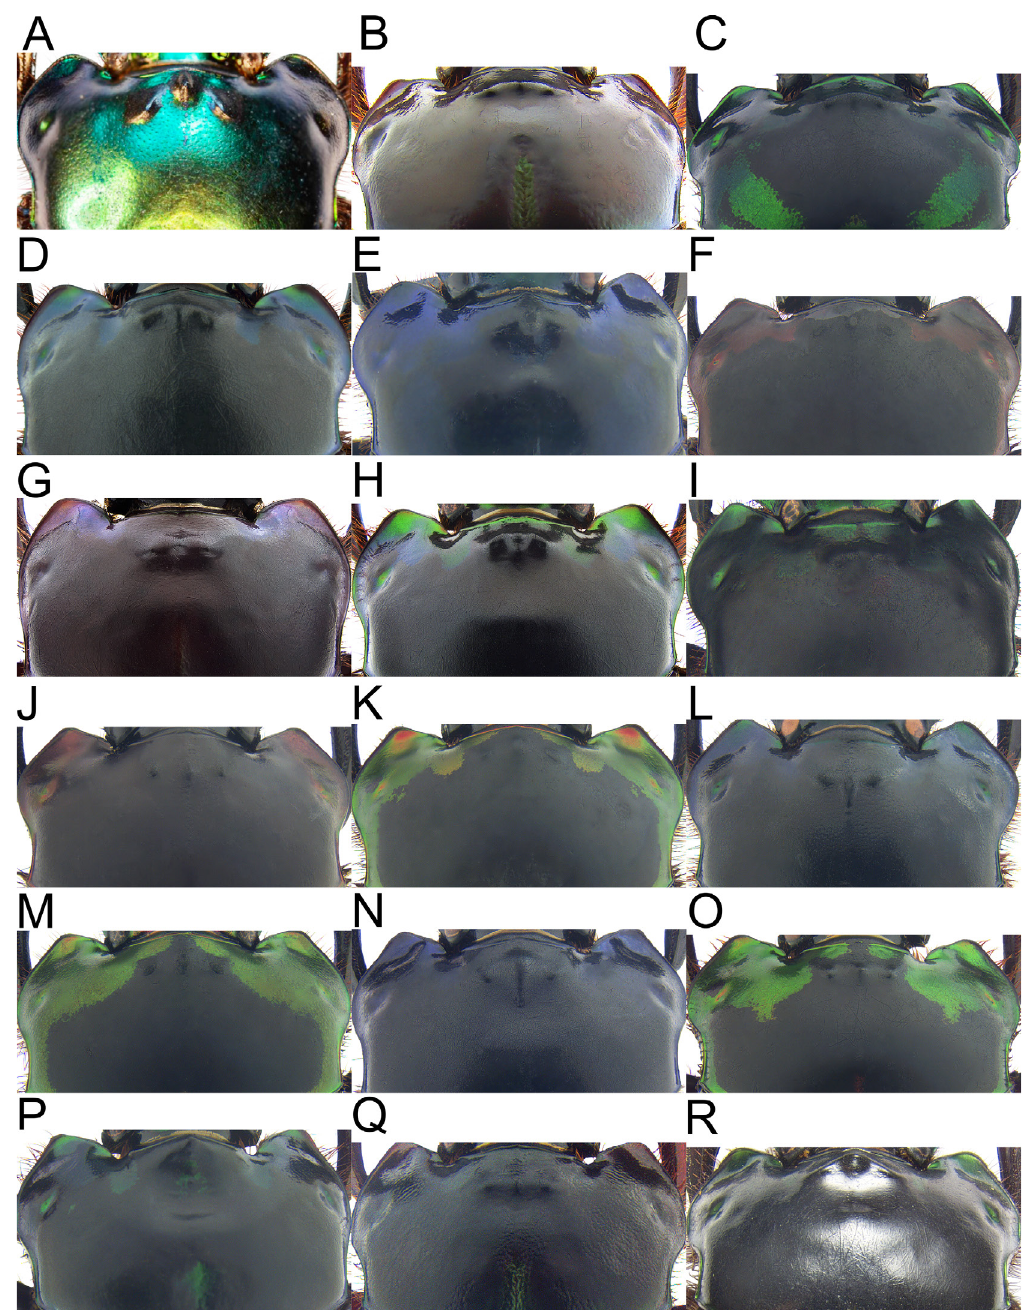
Fig. 18. Pronotum of females within the Phanaeus endymion species group. A . Phanaeus arletteae Arnaud, 2018 (modified from Arnaud 2018). B . Phanaeus bravoensis Moctezuma, Sánchez-Huerta & Halffter, 2017 (by Jose Luis Sánchez-Huerta). C . Phanaeus chiapanecus sp. nov. D . Phanaeus edmondsi Moctezuma, Deloya & Halffter, 2019 (by Jose Luis Sánchez-Huerta). E . Phanaeus endymion